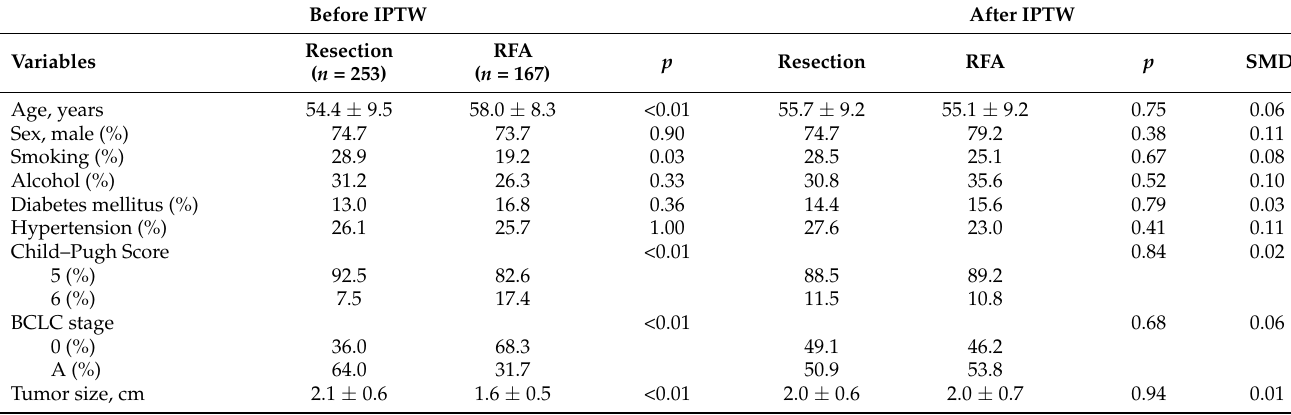
Table 3. Baseline characteristics of the subgroup in the hospital cohort with a single HCC smaller than 3 cm before and after